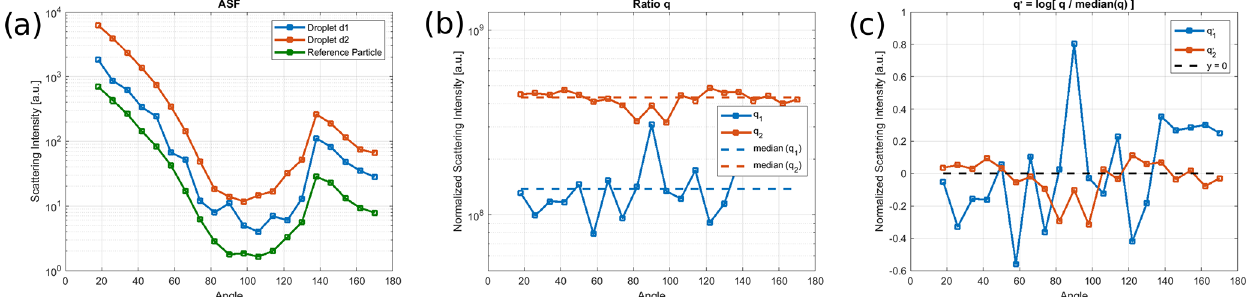
Figure 4. Determination of the feature parameter f 1 of two exemplary droplets: droplet d 1 (blue) is the same particle as used in Fig. 2. Droplet d 2 (red) is a theoretical Mie sphere with d = 200µm. The plots show the particles’ ASFs (a) , q and q (b) and q (cid:48) (c) . The resulting f 1 is then calculated as the integral over all channels (i.e., area between each curve and y = 0). The resulting values are f 1 =3 . 7 for d 1 and f 1 =2 . 2 for d